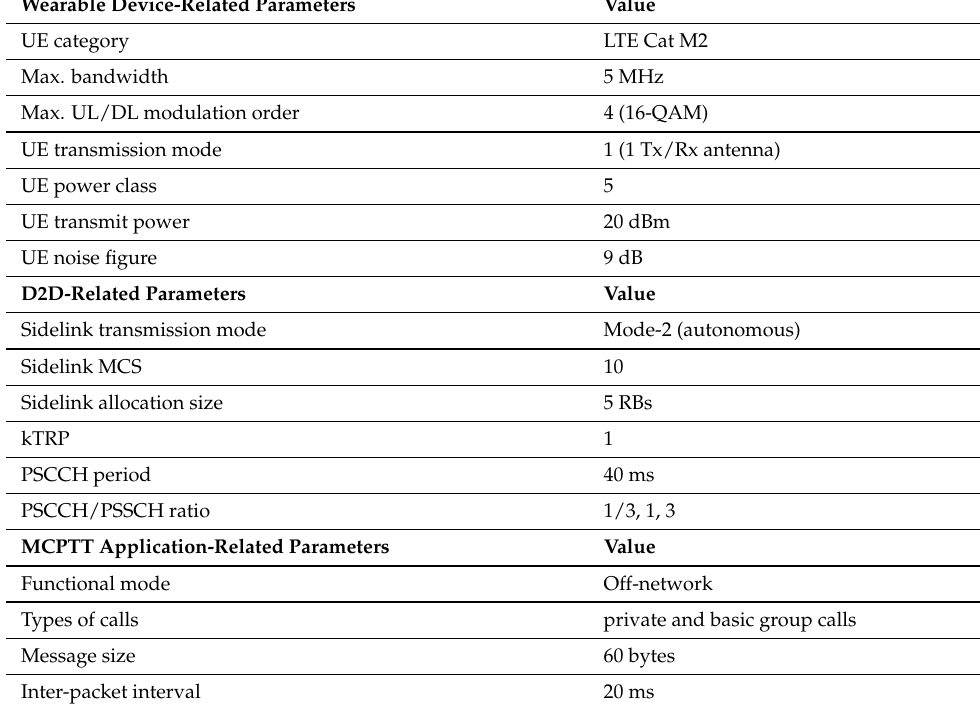
Table 3. Performance evaluation